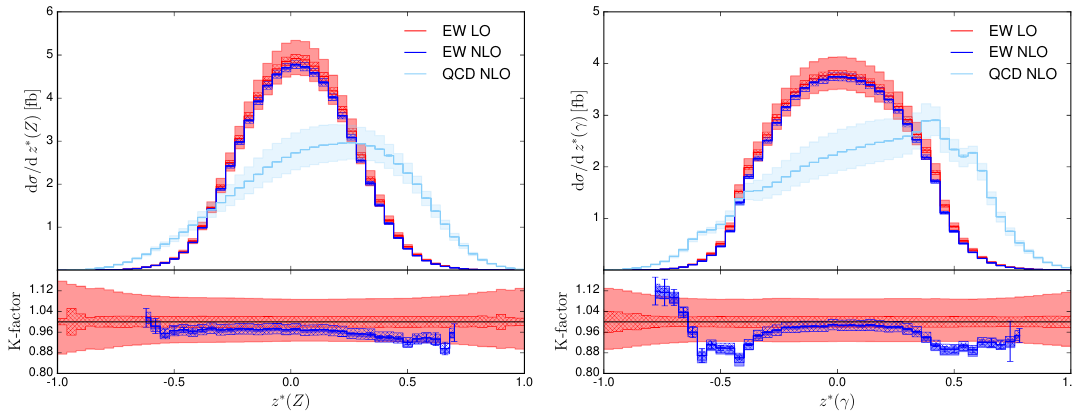
Figure 8 . Di(cid:11)erential cross sections of the EW and QCD induced process, showing the dependence on z (cid:3) de(cid:12)ned in eq. (3.7). The bands show uncertainties associated with the scale and PDF set as described in (cid:12)gure